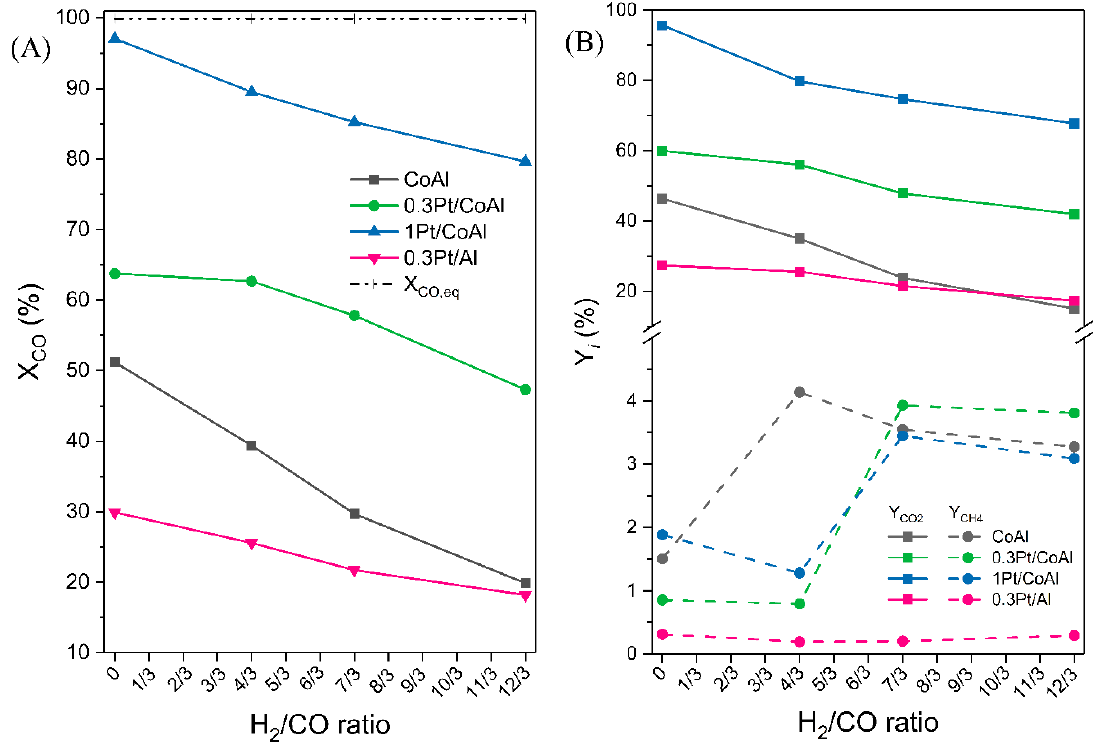
Figure 7. Catalytic activity in the WGS reaction at 260 °C/50 bar and H 2 co-feeding: ( A ) CO conversion and ( B ) product yield. Reaction conditions: W cat = 0.2 g, F H2O = 0.04 mL/min, F CO = 3.5 mL/min.